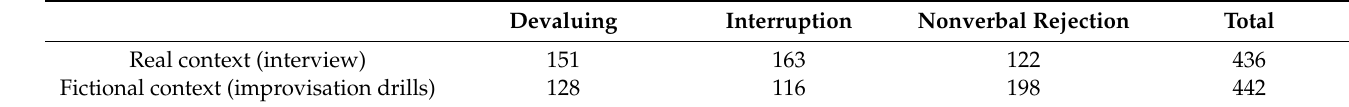
Table 2. Frequencies of REJECTION